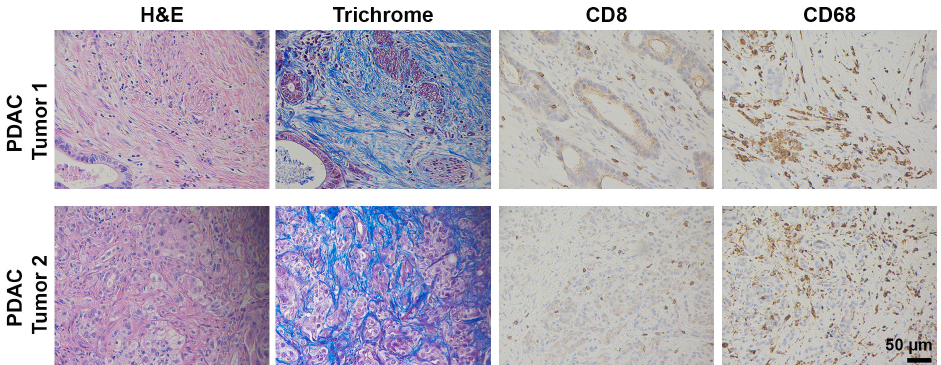
Figure 1. Human PDAC tumors display pronounced desmoplasia and infiltration by macrophages, but lack CD8 + T cells. Human PDAC tumors were H&E or trichrome stained or stained by immunohistochemistry for CD8 + T cells (Abcam, #4055) and the macrophage marker CD68 (Cell Signaling, #76437). Magnification, 20×.